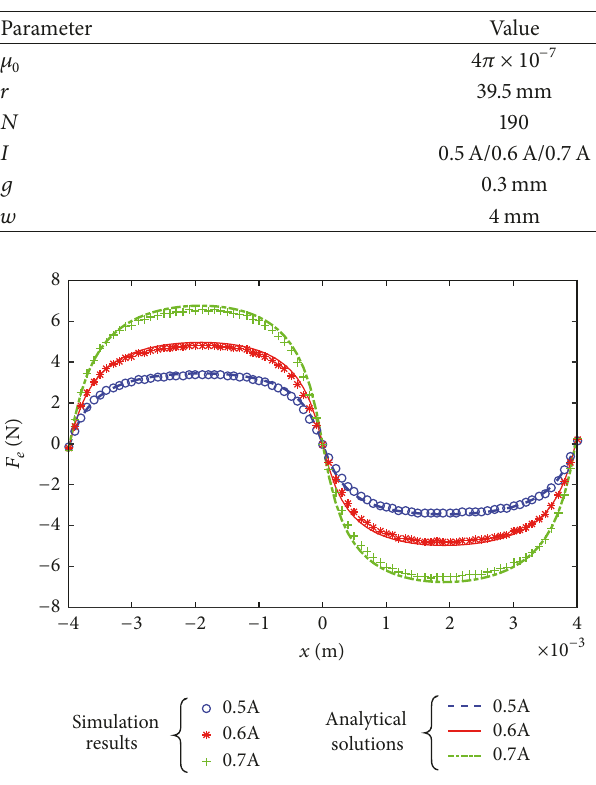
Figure 5: Electromagnetic force of the EATS for various